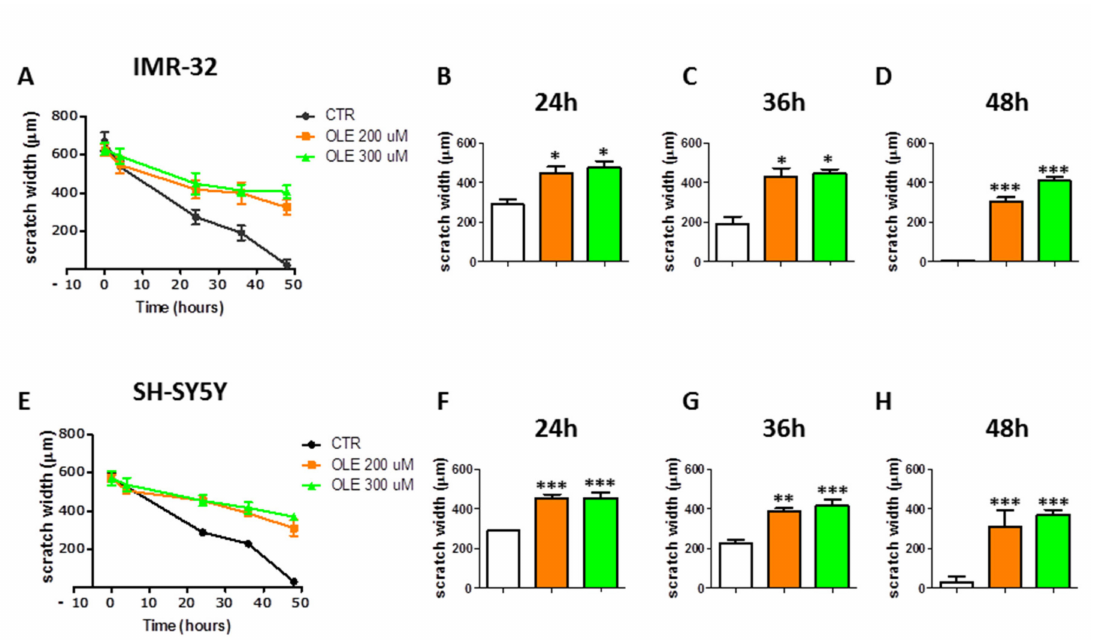
Figure 6. Effects of OLE on the migration of NB cells. ( A ) and ( E ) represent the wound closure curves of CTR vs. OLE-treated cells of IMR-32 and SH-SY5Y, respectively. ( B – D ) and ( F – H ) show the differences of width wound among experimental groups at the indicated time points. Data are expressed as mean ± SD of three independent experiments (* p < 0.05, ** p < 0.01, *** p < 0.001 vs. CTR). CTR: control; OLE: olive leaf extract; uM: micromolar; µ m: micrometer; h: